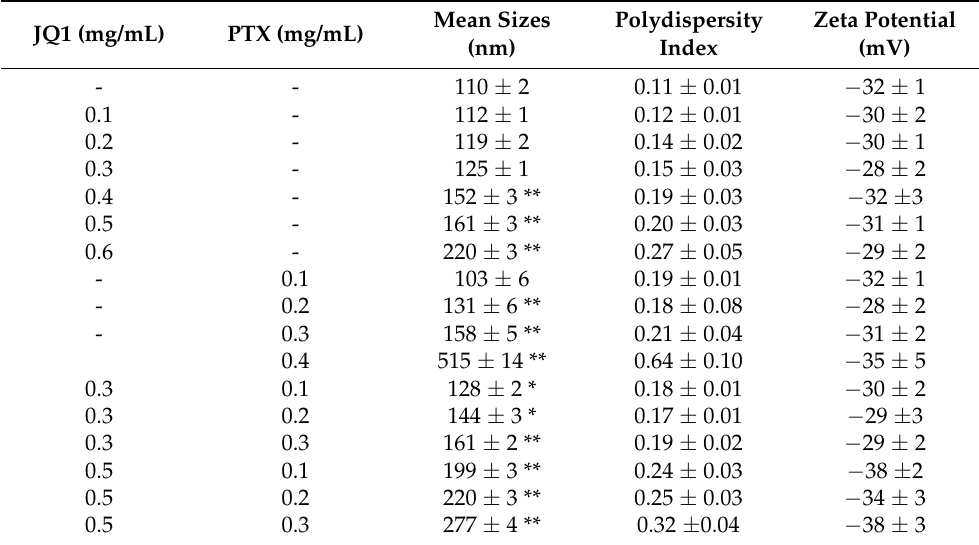
Table 1. Physico-chemical properties of PTX-loaded SD-stabilized zein nanoparticles. JQ1